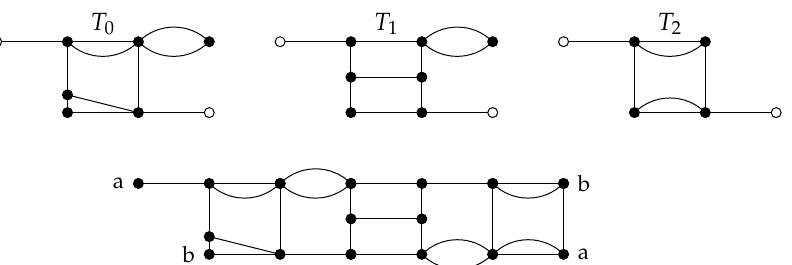
Figure 5. Example for m = 1. For T = ( T 0 , T 1 , T 2 ) , G = ◦ (( ⊗T ) (cid:108) ) is shown. When appropriate white vertices are identified, they are suppressed (see [8] for details).